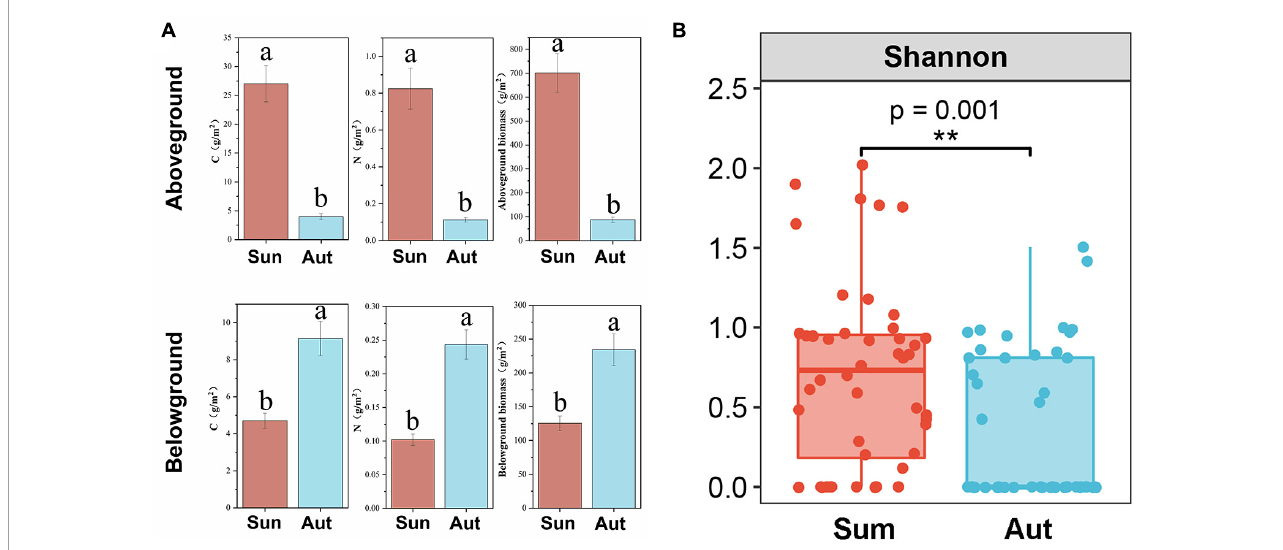
FIGURE4 Plant functional traits and diversity in summer and autumn. (A) C content, N content and biomass of aboveground and belowground in summer and autumn; (B) plant species diversity in summer and autumn. Sum, summer; Aut, autumn; CK, control; G, glyphosate addition; N, chemical nitrogen addition; GN, glyphosate and N addition. Data (a and b) that do not share a letter are significantly different between treatments ( P < 0.05). ** P < 0.01.